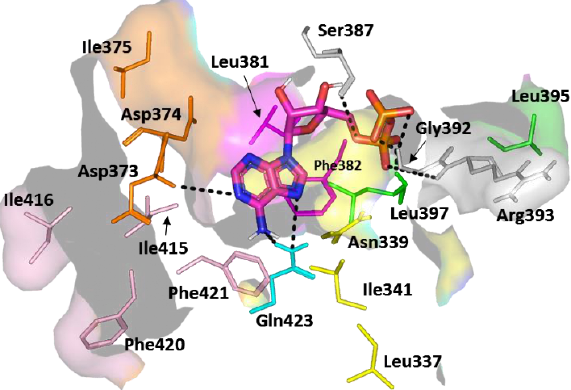
Figure 10. The architecture and predicted ligand–protein binding interactions at ATP-binding domain of S. aureus AgrC histidine kinase. ( A ) Overall 3D cartoon representations of the S. aureus AgrC ATP-binding domain (PDB ID: 4BXI) showing its distinct Bergerat folding in the form of sandwiched α -helices and mixed β -strands. The protein is colored differently in regard to its homology boxes and conservations: G1, G2, G3, F, and N boxes are illustrated in orange, green, pink, purple, and yellow, respectively. The ATP lid connecting G2/F boxes is represented in gray color. ( B ) Surface representation of the ATP-binding domain with key pocket residues (lines) involved in ADP binding. ( C ) Overlay of investigated compounds (SIT, OMR, and TRG as cyan, green, and purple lines, respectively) and ADP- β - N (magenta sticks) binding to the protein’s canonical binding site. ( D – G ) Predicted binding modes of the docked ligands (cyan or magenta sticks): ( D ) SIT, ( E ) TRG, ( F ) OMR, and ( G ) ADP- β -N. Residues are colored based on their respective homology boxes and labeled with sequence numbers. Non-polar hydrogens are removed for clarity. Hydrogen bonding is depicted as black dashed lines.